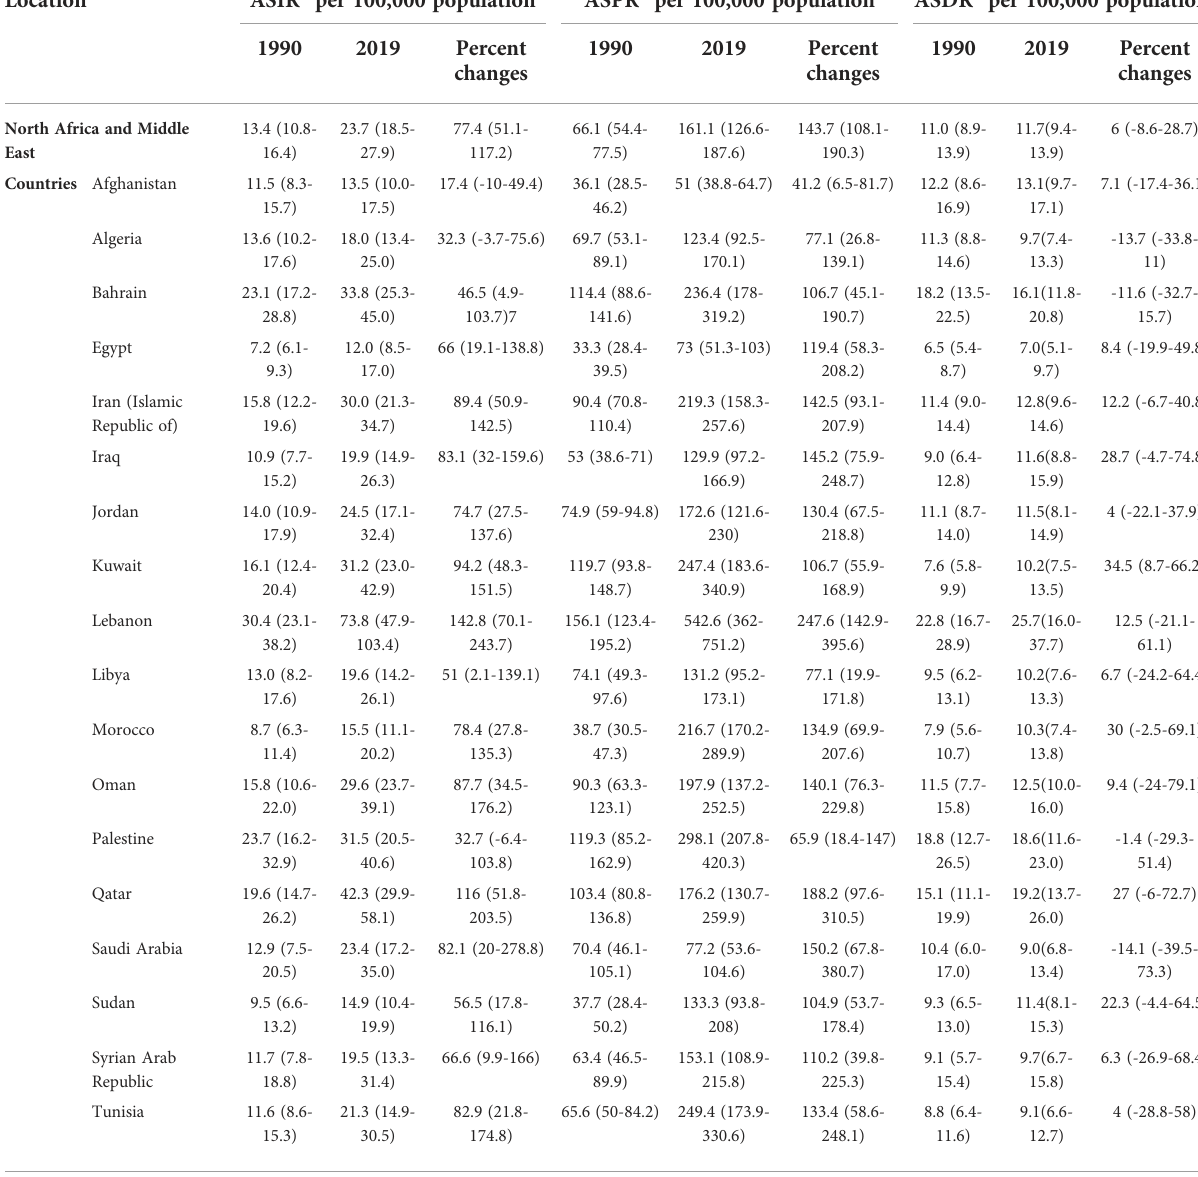
TABLE 1 Age-standardized rates (95% UI) for incidence, prevalence, and death due to prostate cancer in 1990 and 2019 and their percent changes. Location ASIR 1 per 100,000